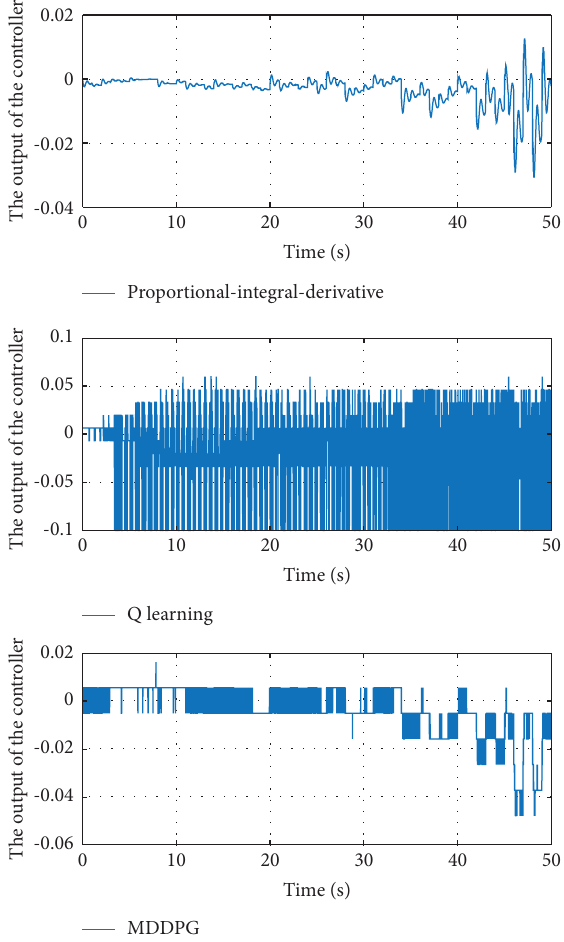
Figure 12: Curves of rotor angle deviations obtained by compared methods.